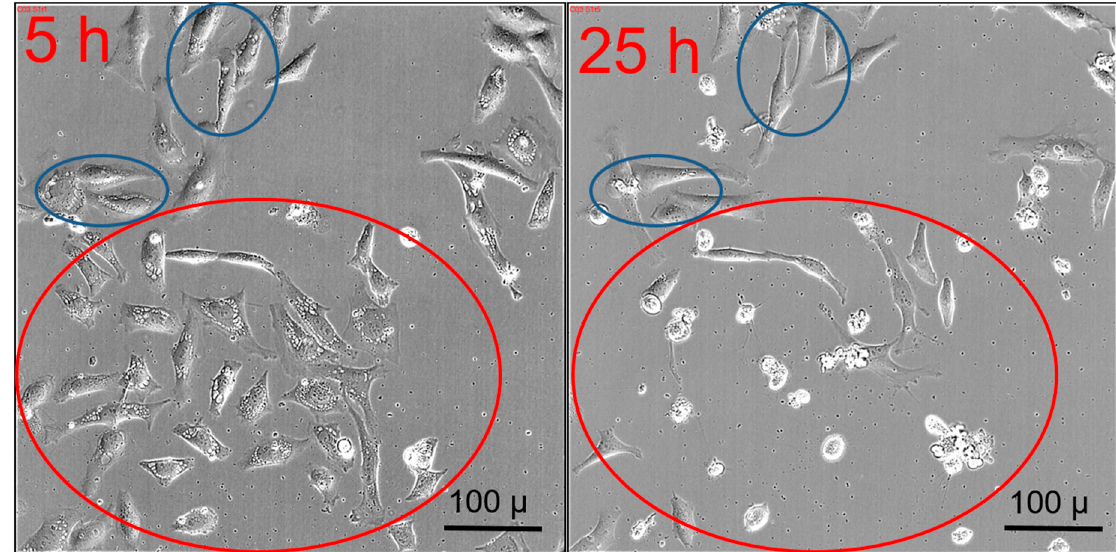
Figure 6. Morphological changes observed in HeLa cells at different post-incubation times after exposure to 1.2 µg curcumin (32 µM). Left: pore formation around the nuclear envelopes after 5 h that develop into dead cells after 25 h as shown on the right (highlighted in red). Highlighted in blue are cells that were able to recover.